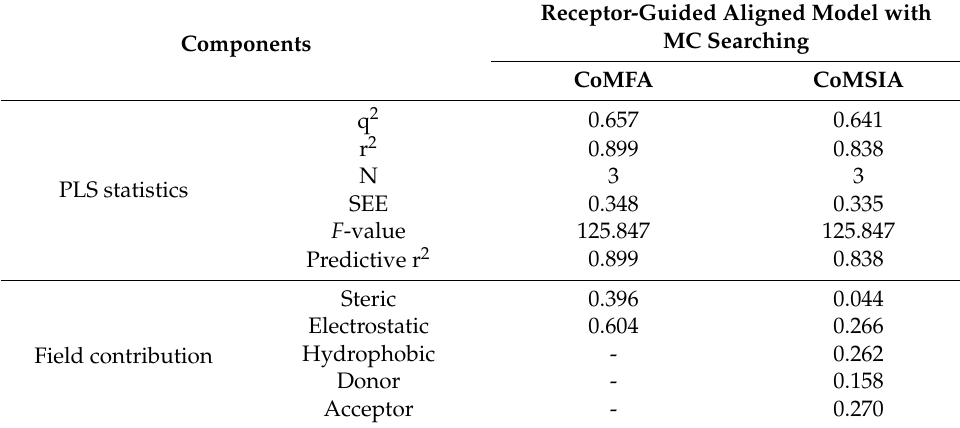
Table 1. PLS results of final CoMFA and CoMSIA